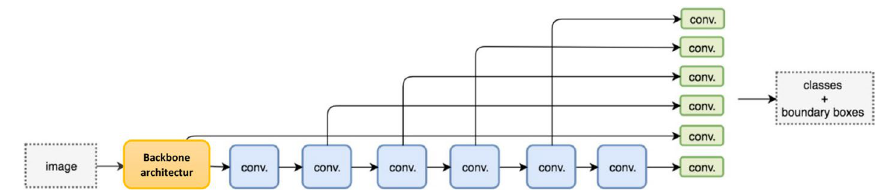
Fig. 10 Multiscale downscaling layer (auxiliary layer)